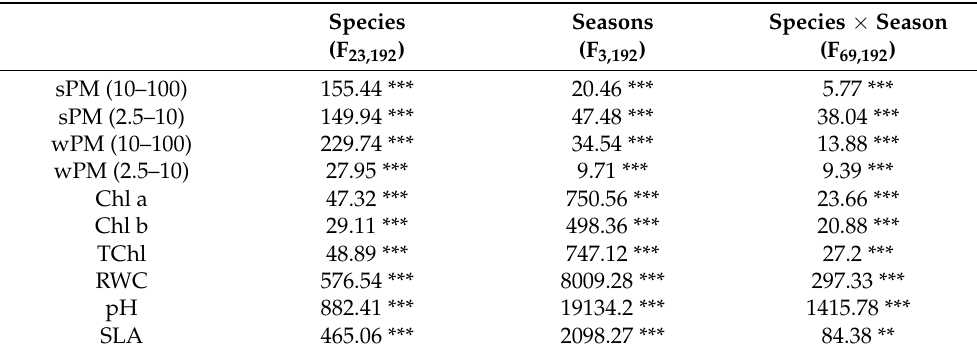
Table 4. ANOVA analysis of PM accumulation on the leaf and leaf traits of 24 plant species in the four seasons (spring, summer, autumn, and winter).